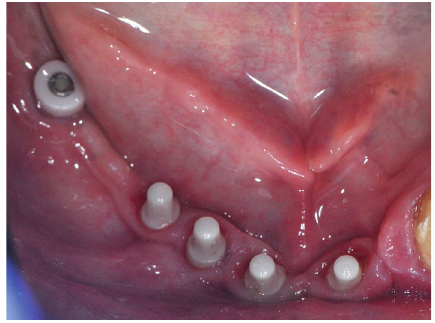
Figure 10: Clinical view before prosthesis positioning.